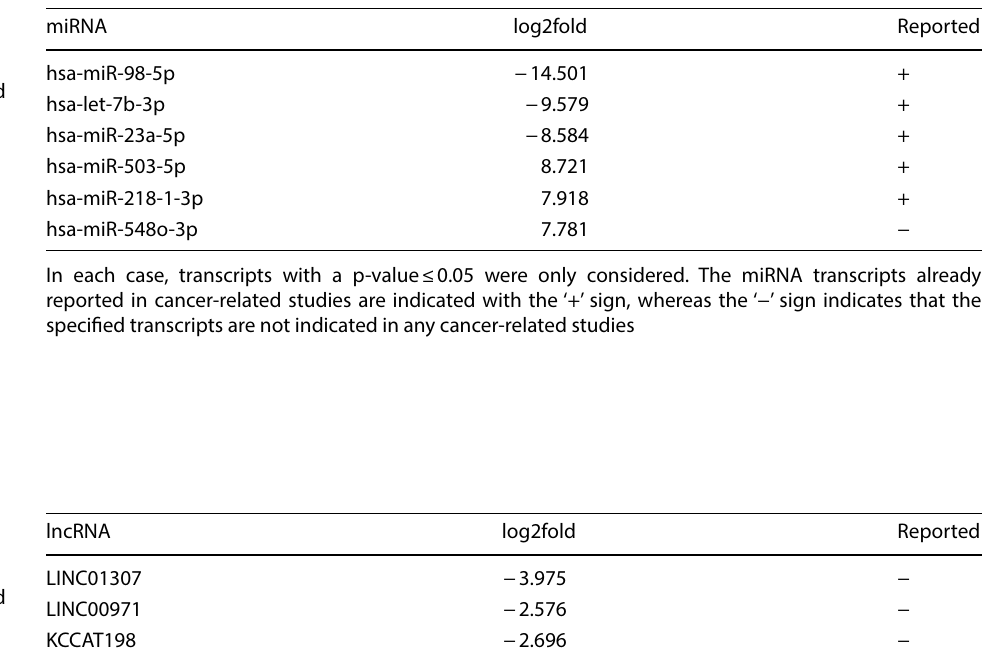
Table 13 Top three downregulated and upregulated miRNA transcripts in OS-R compared to OS cells